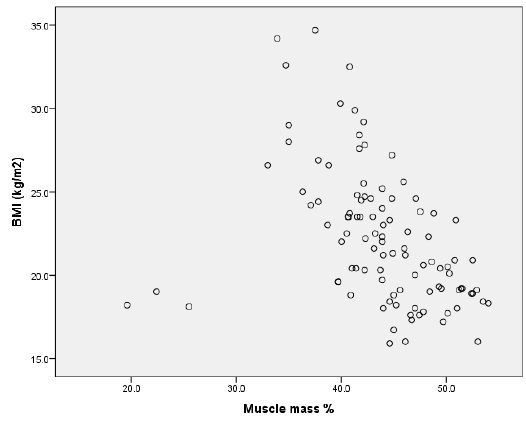
Figure 12. Correlation between BMI and percentage muscle mass per group.